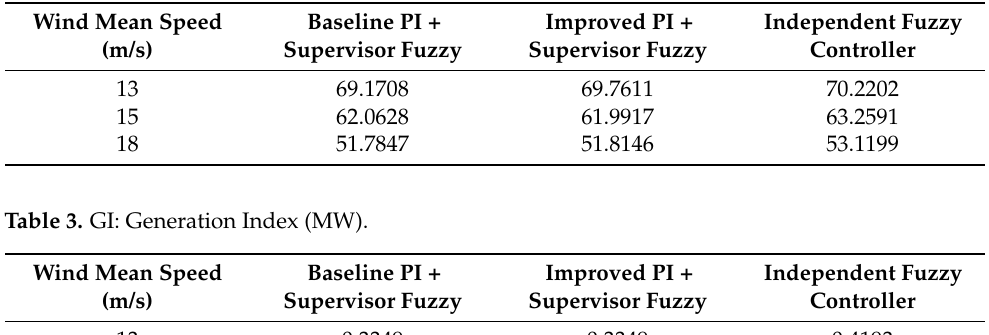
Table 2. StI: Structural Index (MN · m).